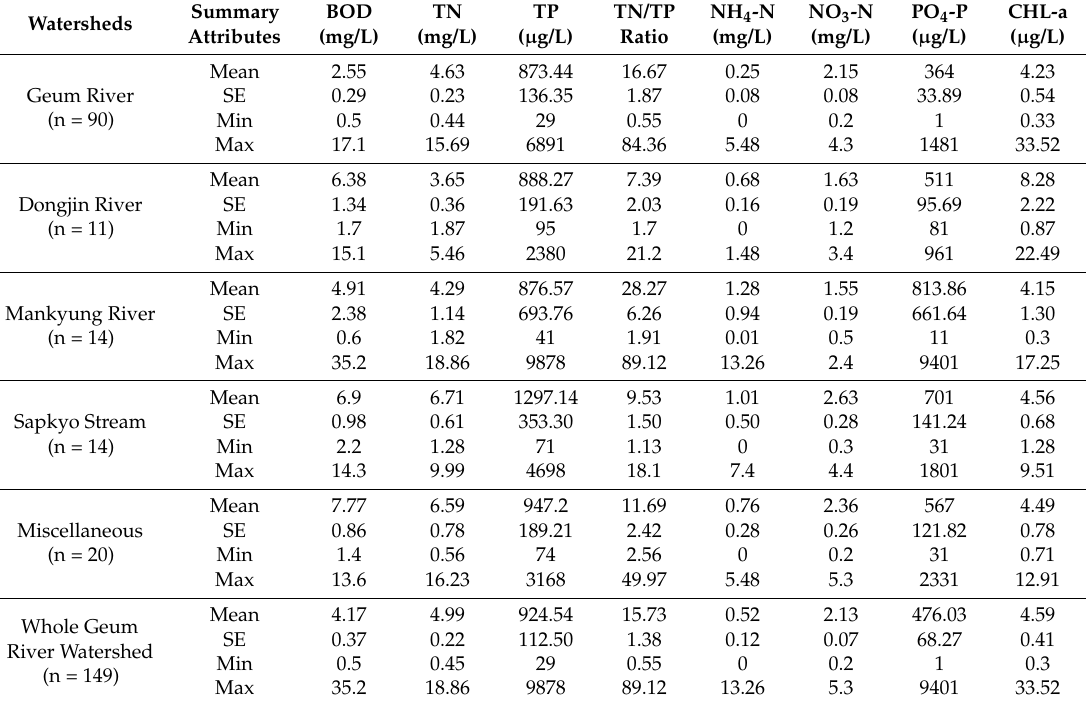
Table 4. Summary statistics of selected water chemistry parameters in Guem River